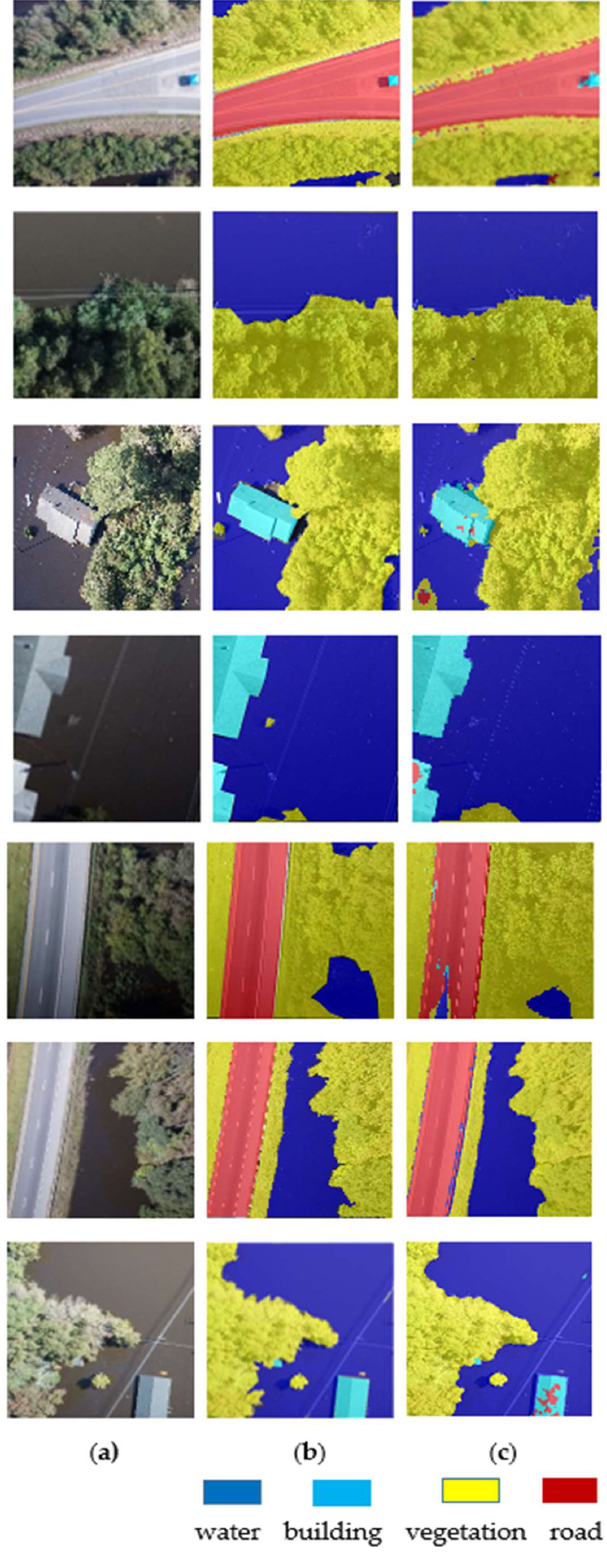
Figure 5. Classification results of the FCN-16s. ( a ) Original RGB images; ( b ) labelled images (ground truth); ( c ) results of FCN-16s classification.